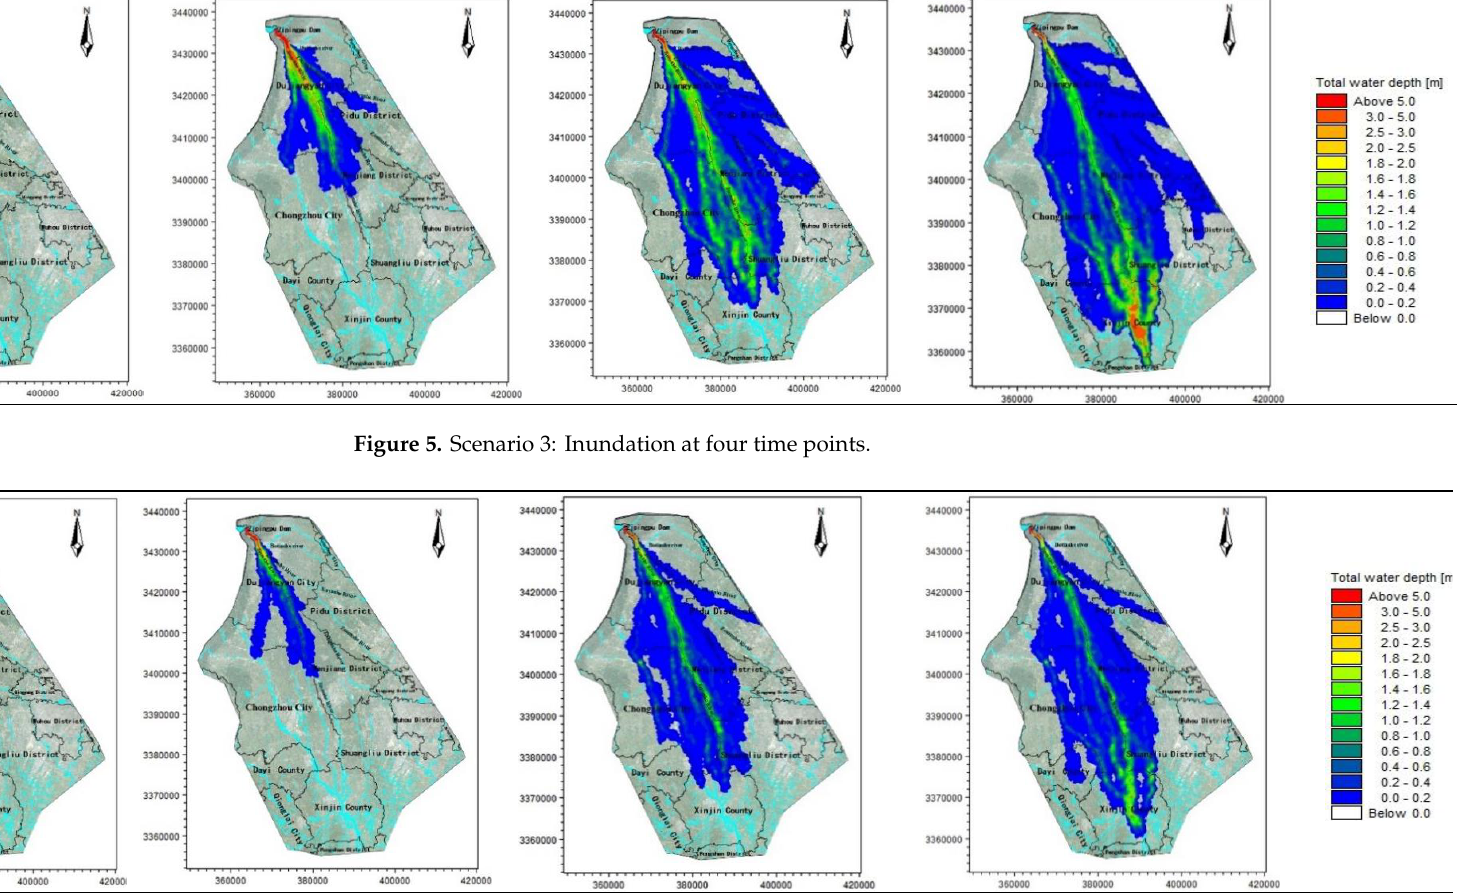
Figure 6. Scenario 4: Inundation at four time points.